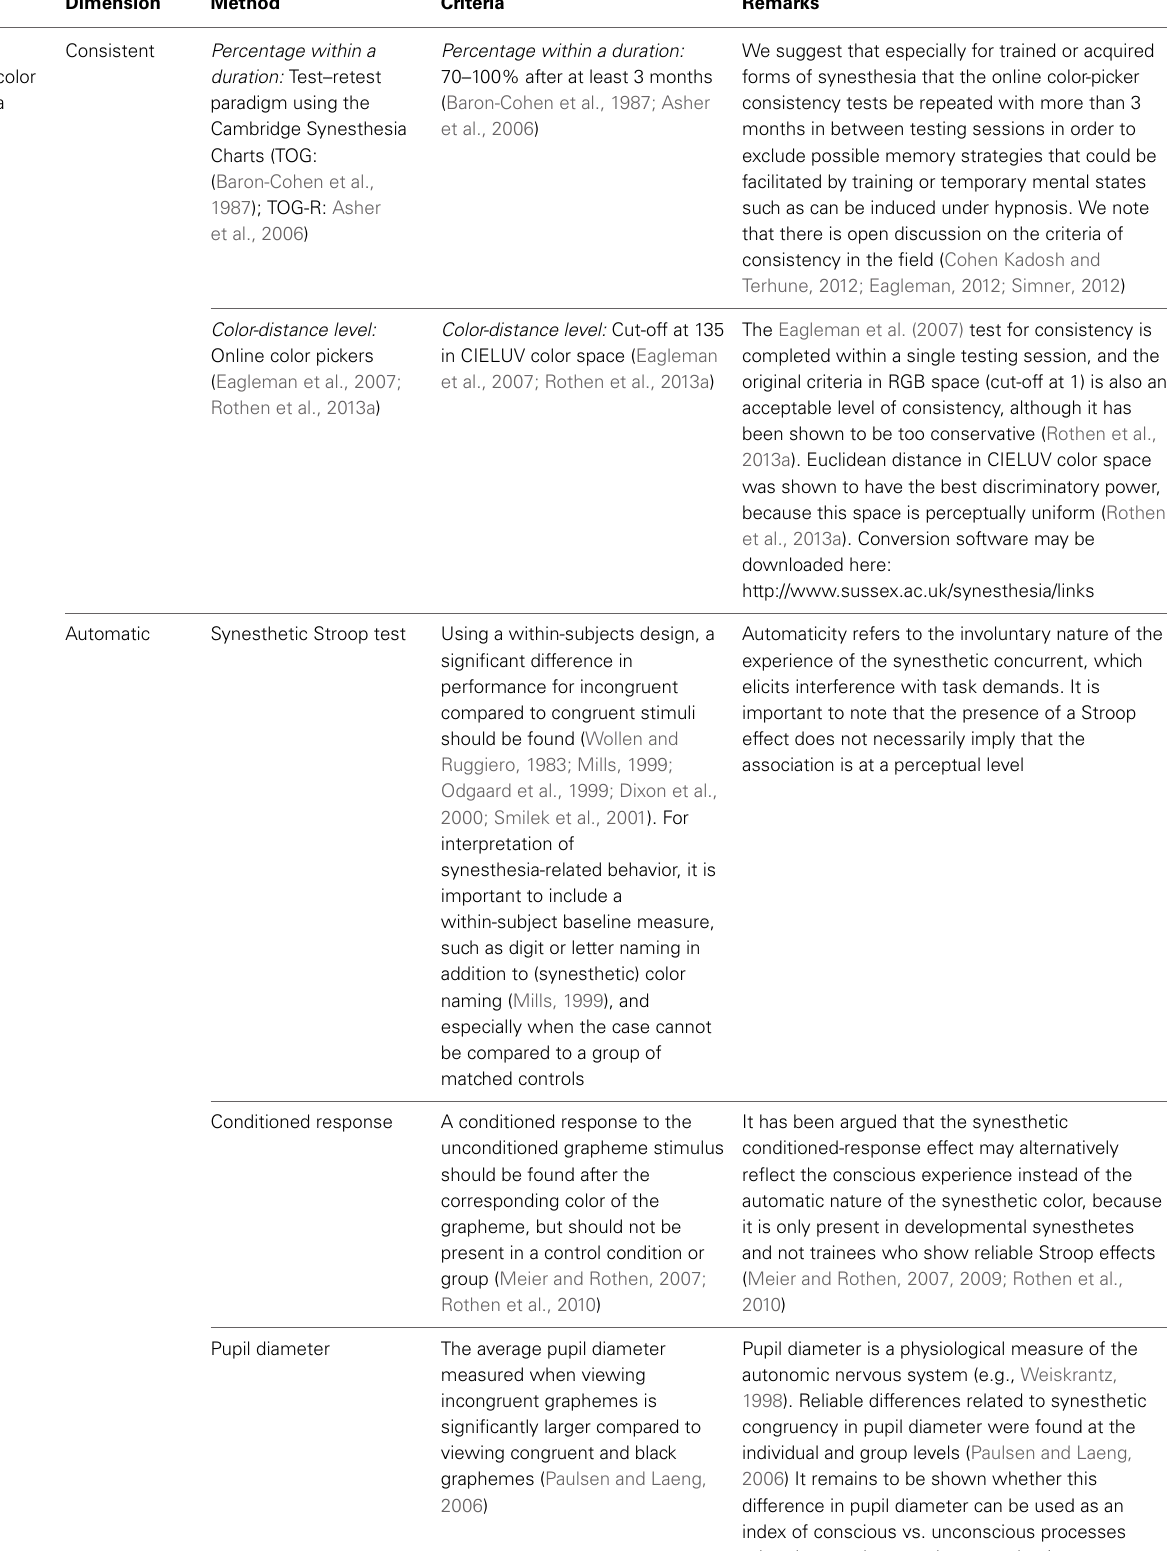
Table 1 | Proposed diagnostic criteria for grapheme-color synesthesia at the level of a single individual.